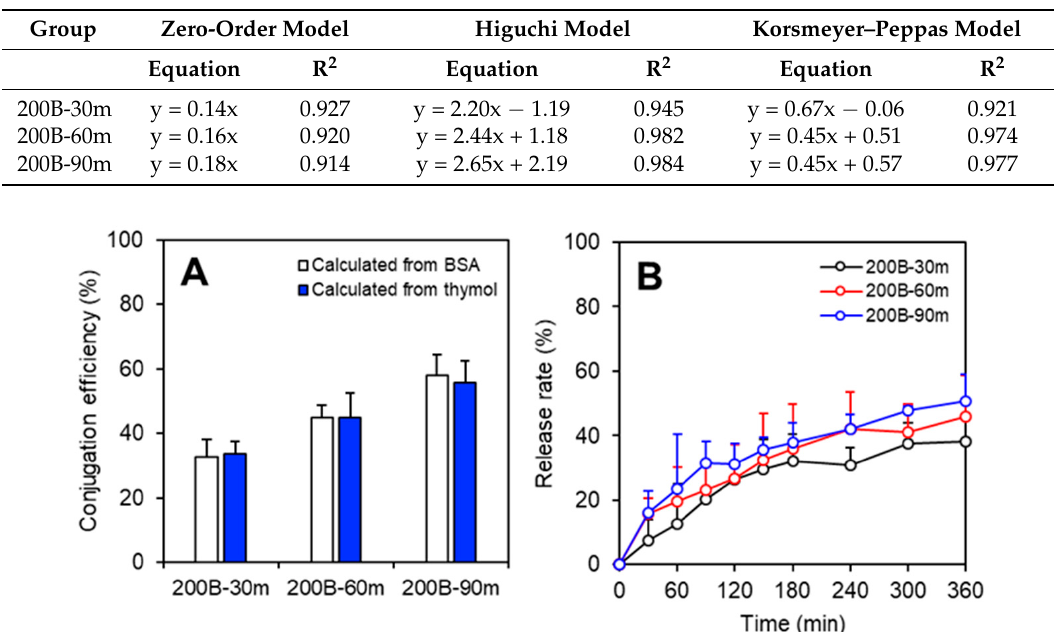
Figure 5. ( A ) Conjugation efficiency of SLPN on chitosan beads from different calculation methods; ( B ) release profile of thymol from nanoparticles.